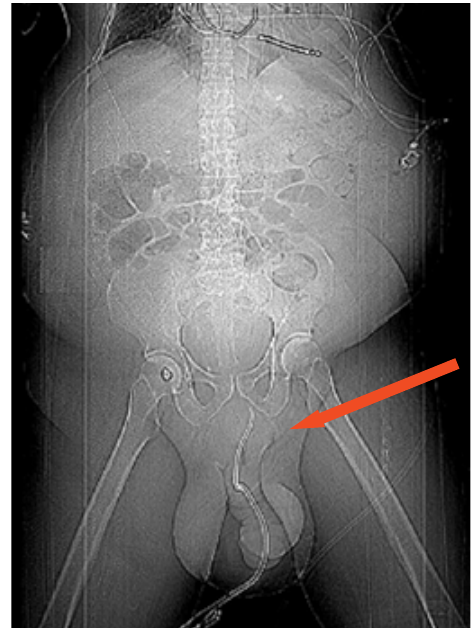
figure 1 – Ominous deviation of the tip of the catheter to the left